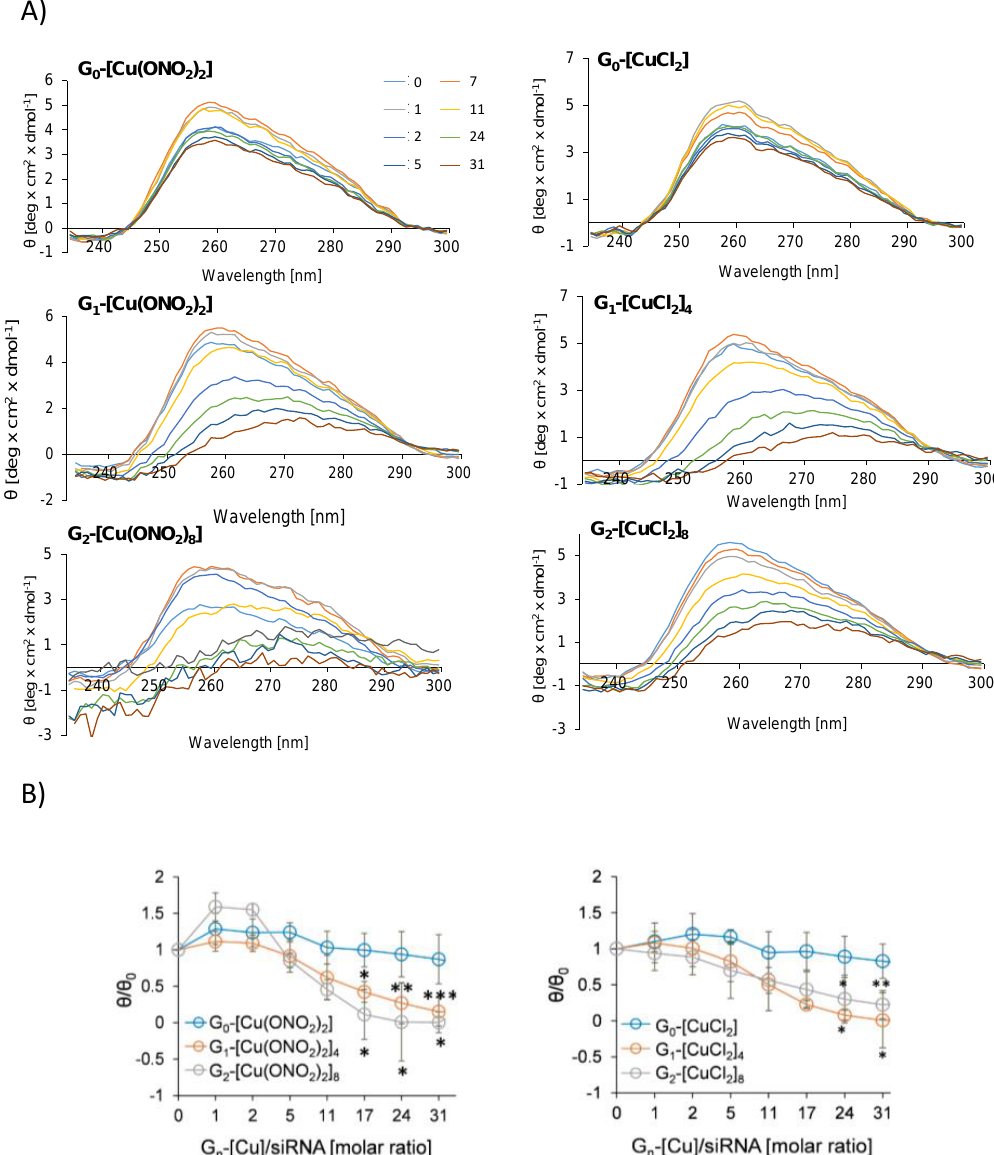
siRNA. Analysis of the changes in θ / θ 0 parameter at 258 nm showed that at this wavelength, ellipticity values reached a plateau at a molar ratio G n -[Cu] / siRNA of 10 for G 1- [Cu(ONO 2 ) 2 ] 4 , G 2- [Cu(ONO 2 ) 2 ] 8 , G 1- [CuCl 2 ] 4 1 and 8 for G 2- [CuCl 2 ] 8 .